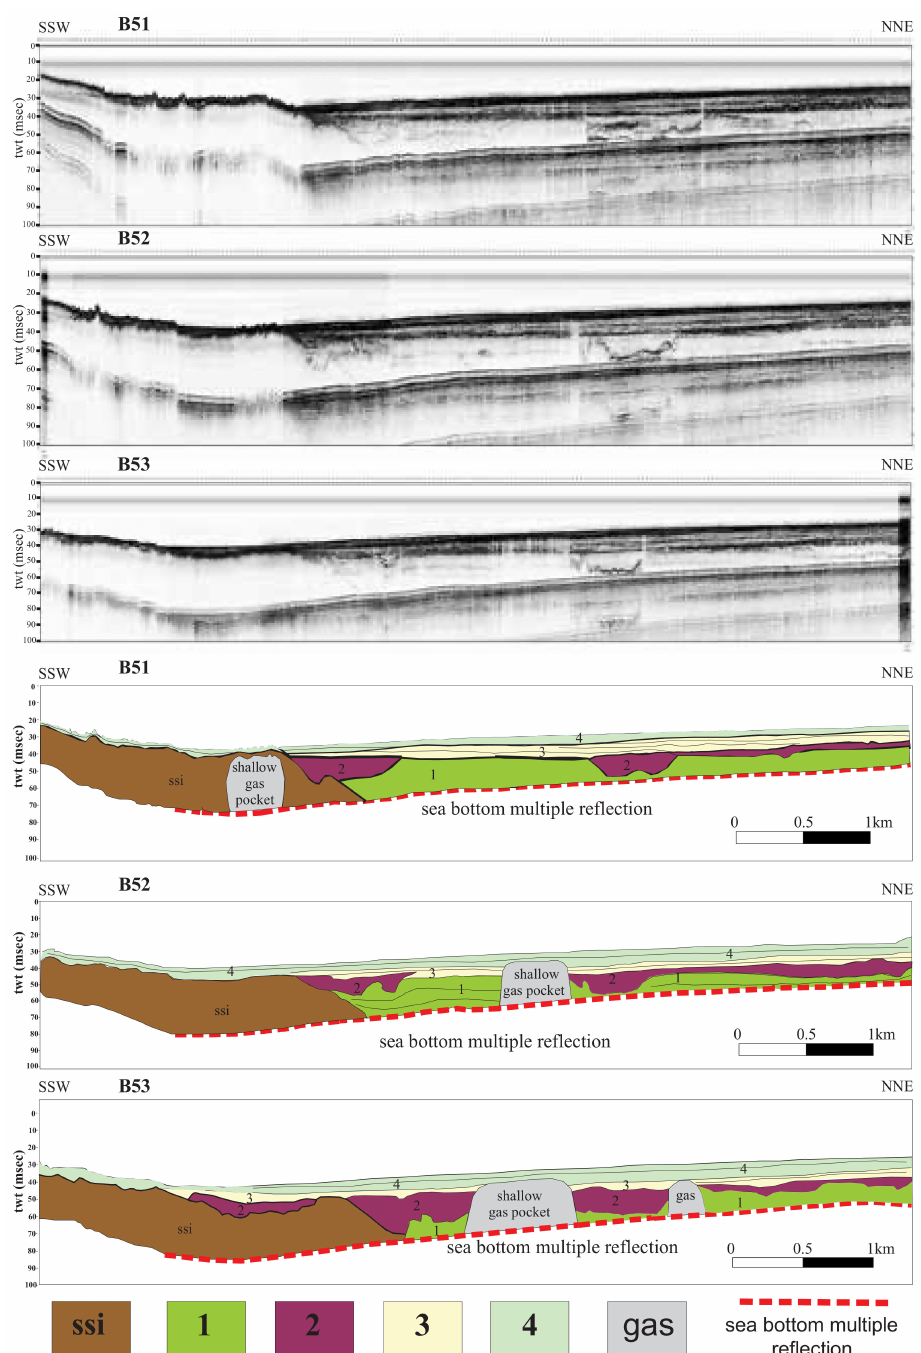
Figure 7. Sub-bottom profiles B51, B52 and B53 and the corresponding geological interpretations (see Figure 3 for